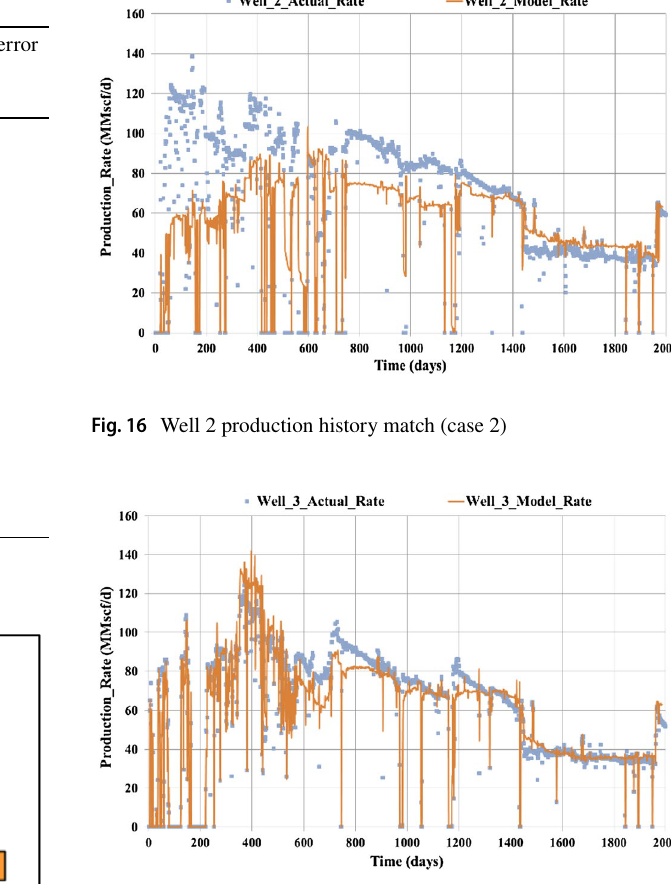
Fig. 17 Well 3 production history match (case 2)